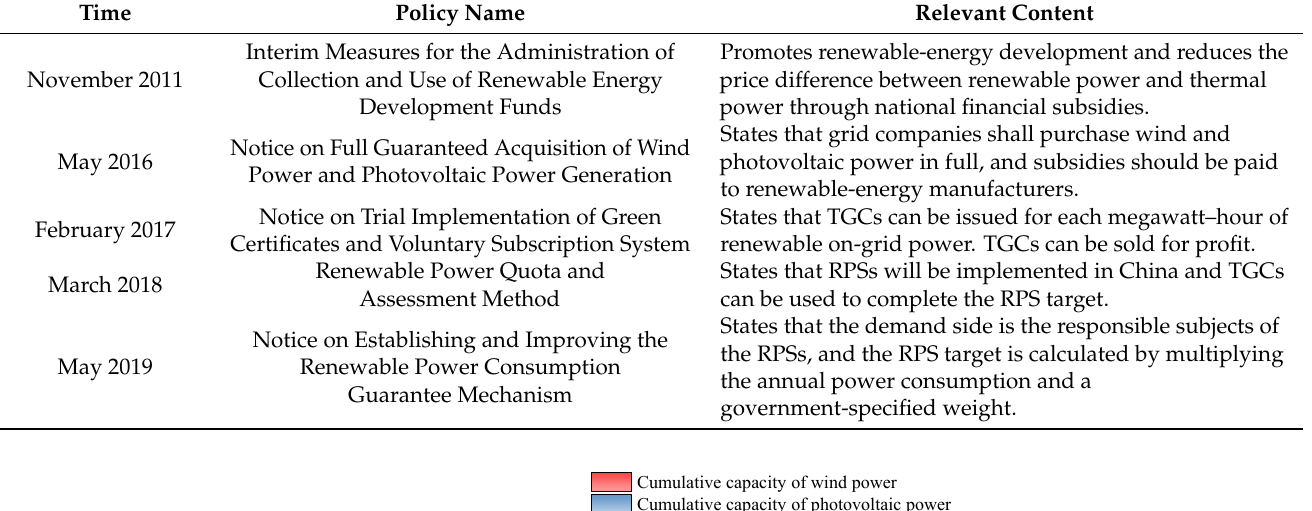
Table 1. Relevant policies issued by China.